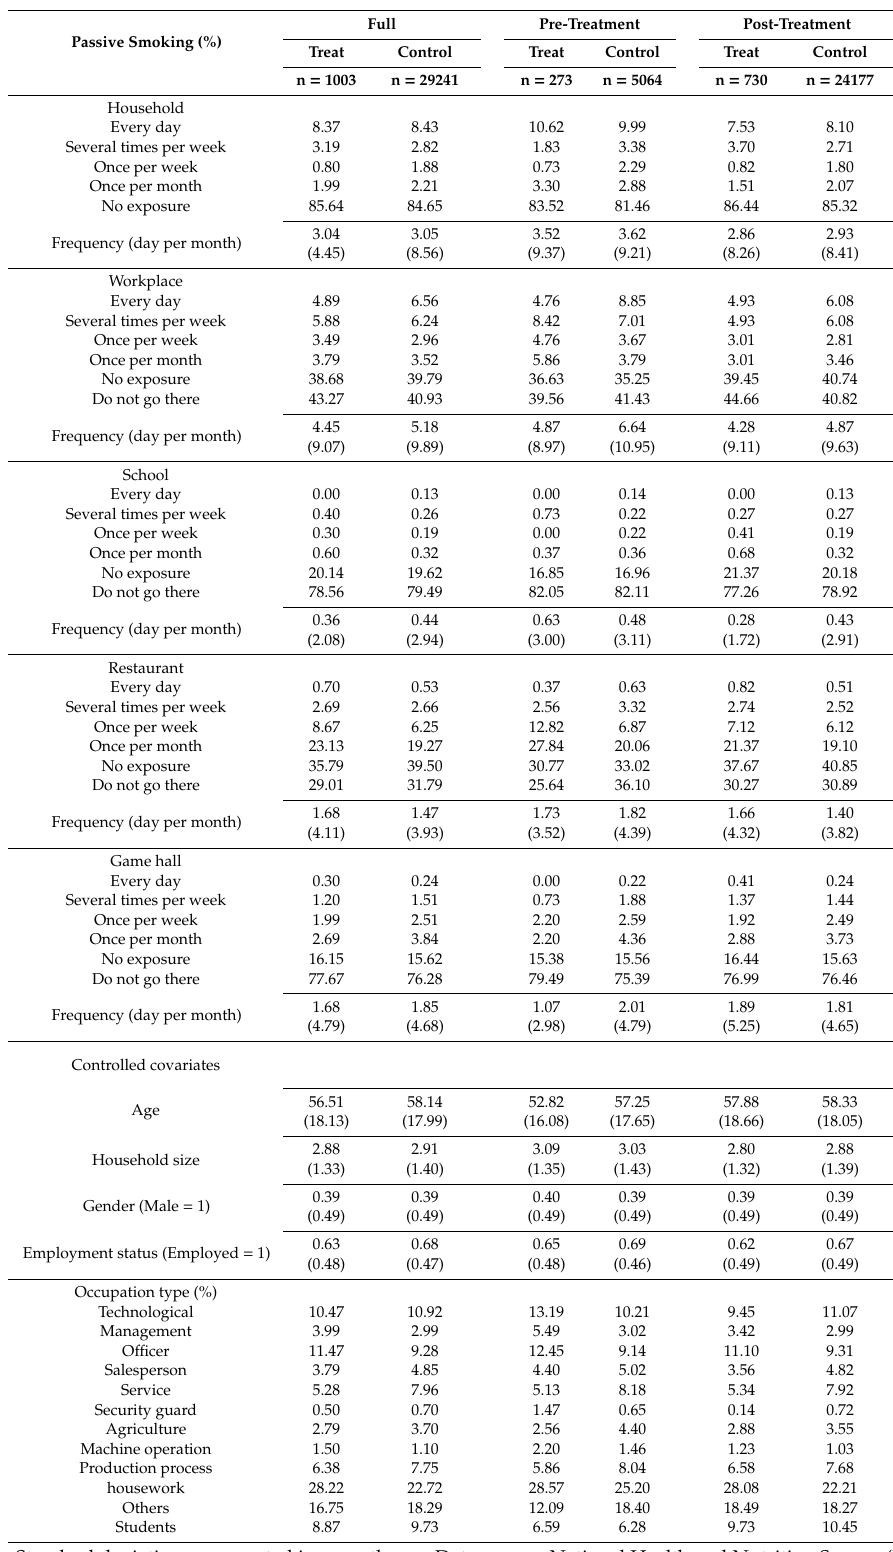
Table 1. Descriptive statistics of analytical sample for passive